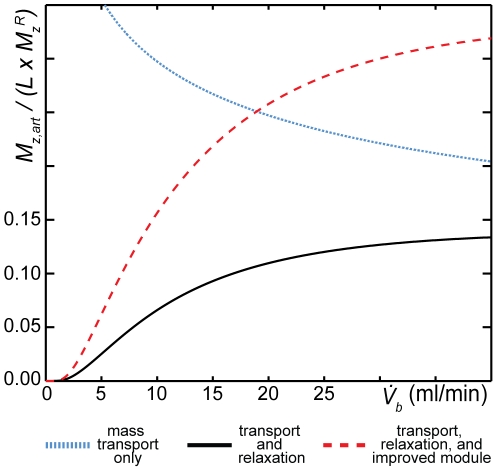
Simulated magnetization dynamics.Dissolved magnetization, in the absence of reservoir relaxation, is expressed as a fraction of its maximum possible value (i.e., the product of the gas-phase magnetization and the Ostwald solubility of xenon in blood). The dotted blue curve assumes the physical characteristics of the module used in this work but neglects dissolved-phase relaxation and thus represents only mass transport across the membranes. The solid black curve includes relaxation in the blood. The dashed red curve also accounts for relaxation in the blood but assumes that the module has been improved by doubling the membrane surface area to 200 cm2.